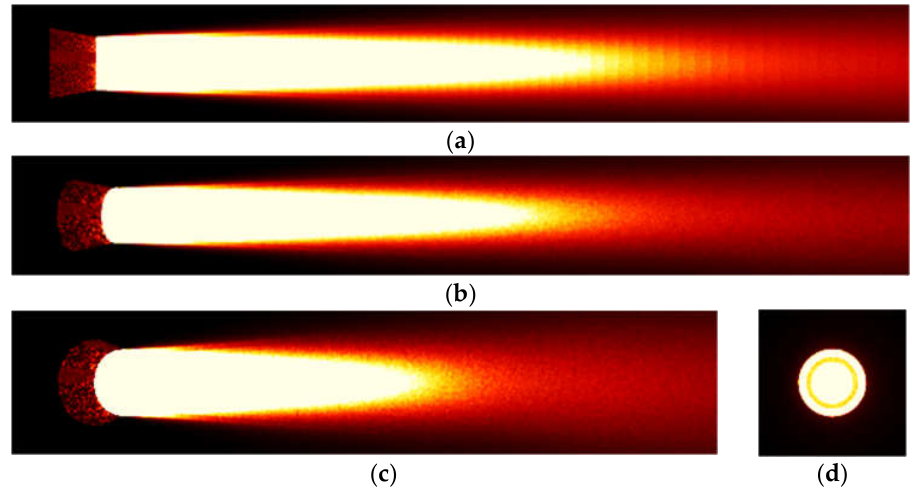
Figure 12. Infrared image of 3–5-μm band. ( a ) 90°; ( b ) 60°; ( c ) 30°; ( d ) 30°.